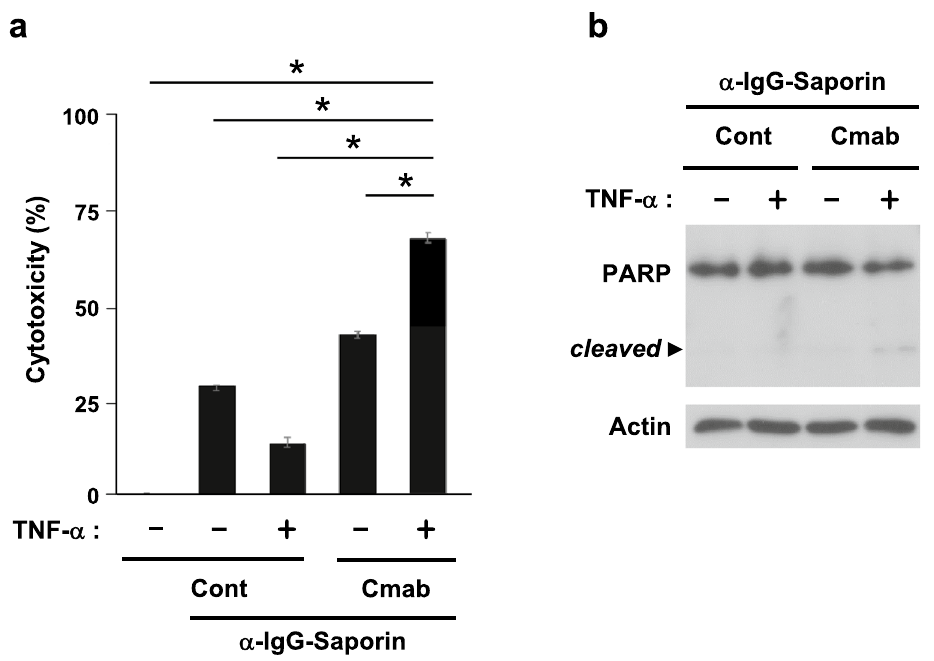
Figure 5. Effects of a second immunotoxin on cell proliferation. ( a , b ) HeLa cells were pretreated with 100 nM cetuximab and 5 nM saporin-conjugated anti-human IgG antibody (α-IgG-Saporin) for 30 min and then stimulated with 20 ng/mL TNF-α for 24 h. The cytotoxicity ( a ) and cleavage of PARP ( b ) were analyzed by the WST-8 assay and immunoblotting, respectively. Cytotoxicity was calculated using the values of cell proliferation in the absence of the trimer complex. Original blots are published in Supplementary Fig. S3. Values are shown as the mean ± SD. * p <